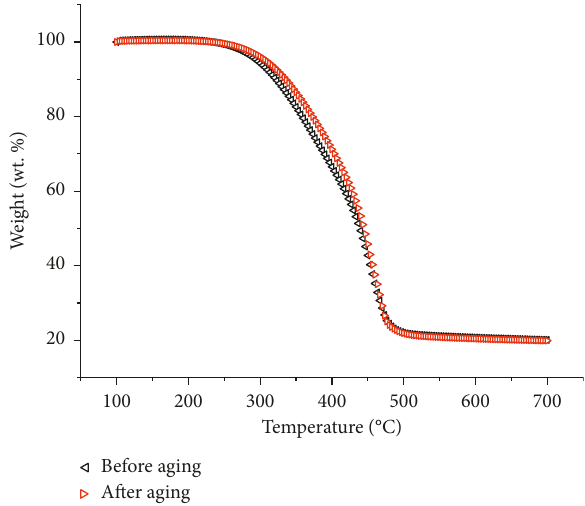
Figure 6: TG curves of WPP-modified asphalt before and after aging.